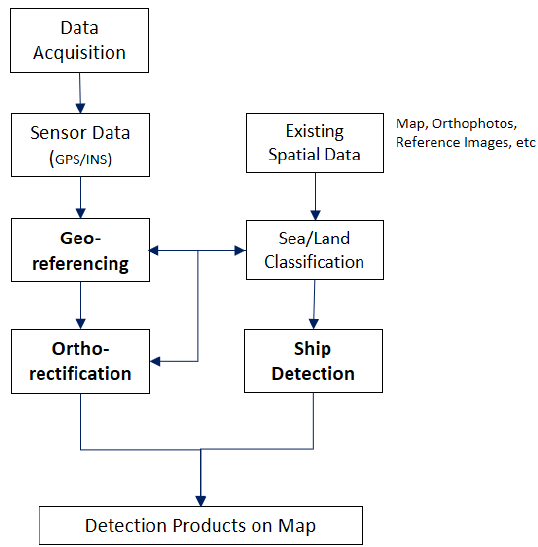
Figure 4. Flowchart of real-time processing